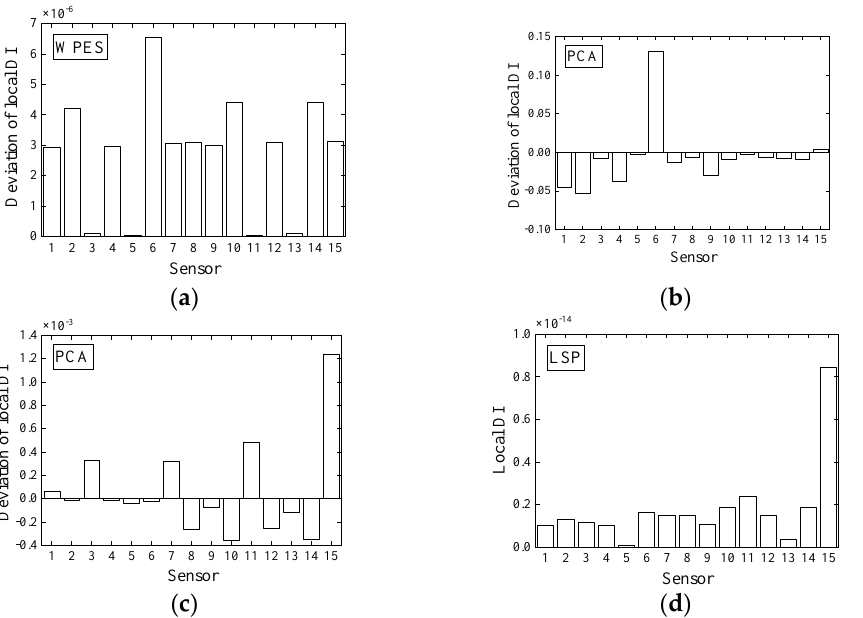
Figure 11. Deviations of local damage indicators corresponding to ( a ) WPES-only and WPES-based ( b , c ) PCA and ( d ) LSP methods respectively, when the second damage (2nd DS) occurs (i.e., 221 s). Note: WPES-based PCA method yields two results due to the different baselines used.